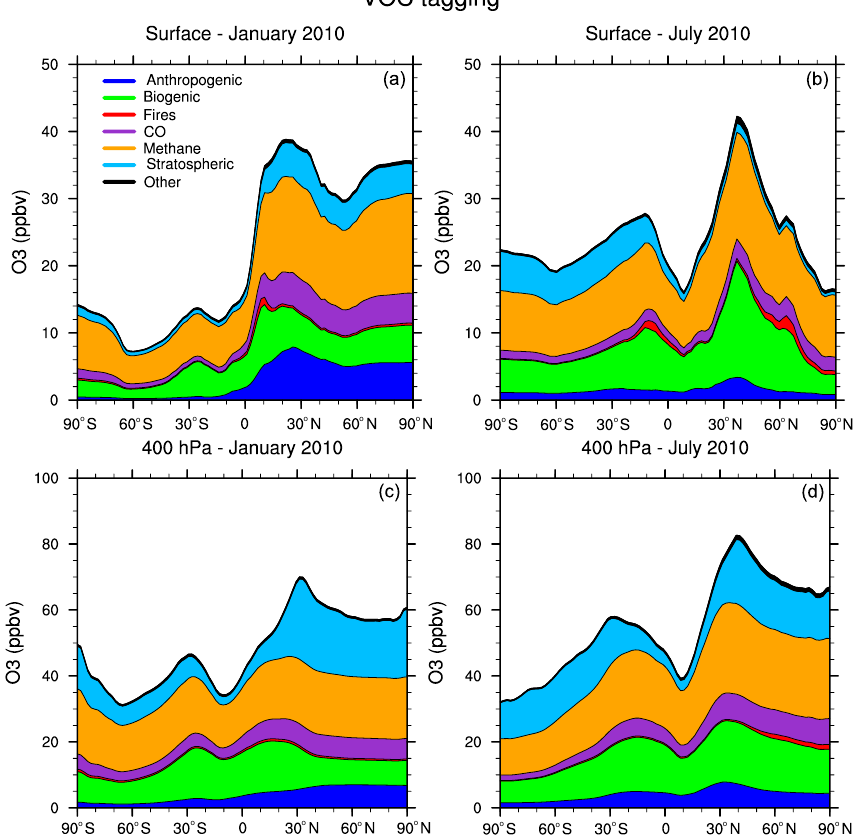
Figure 6. Zonal average of tagged ozone source contributions at the surface (a, b) and at 400hPa (c, d) for January (a, c) and July (b, d) from the VOC-tagging